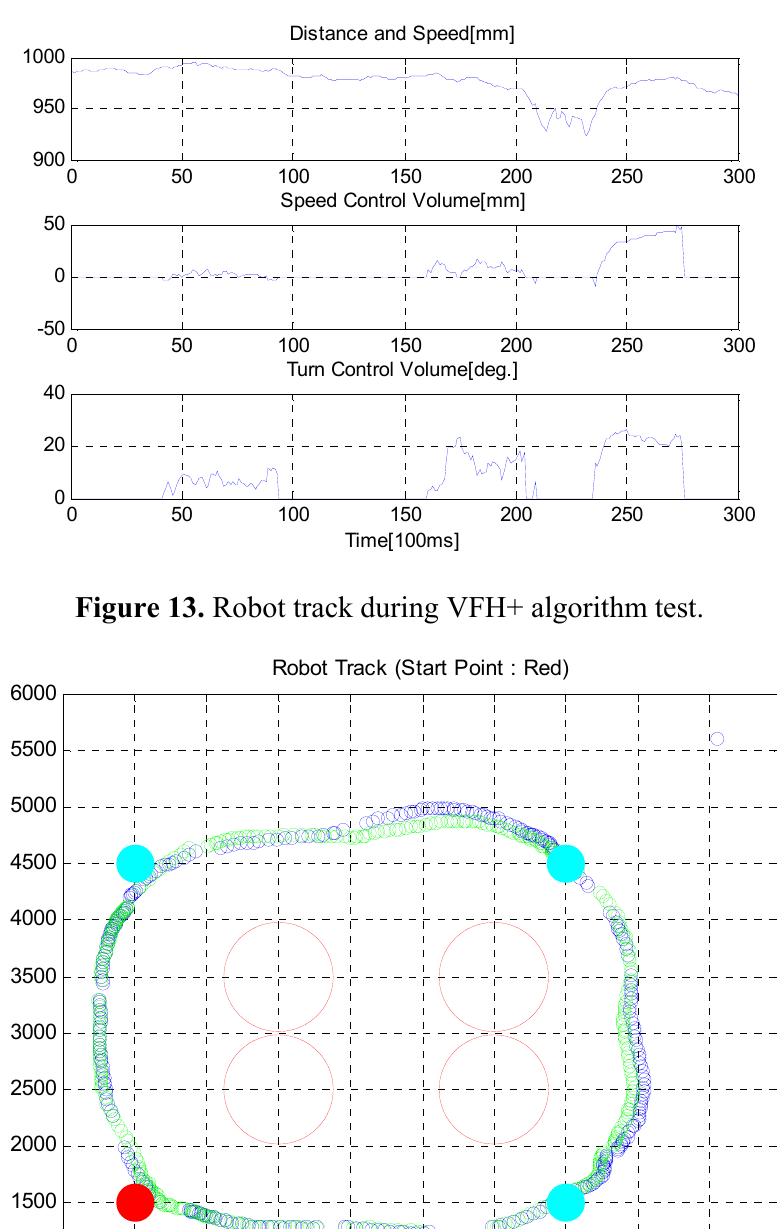
Figure 12. Sensor output.